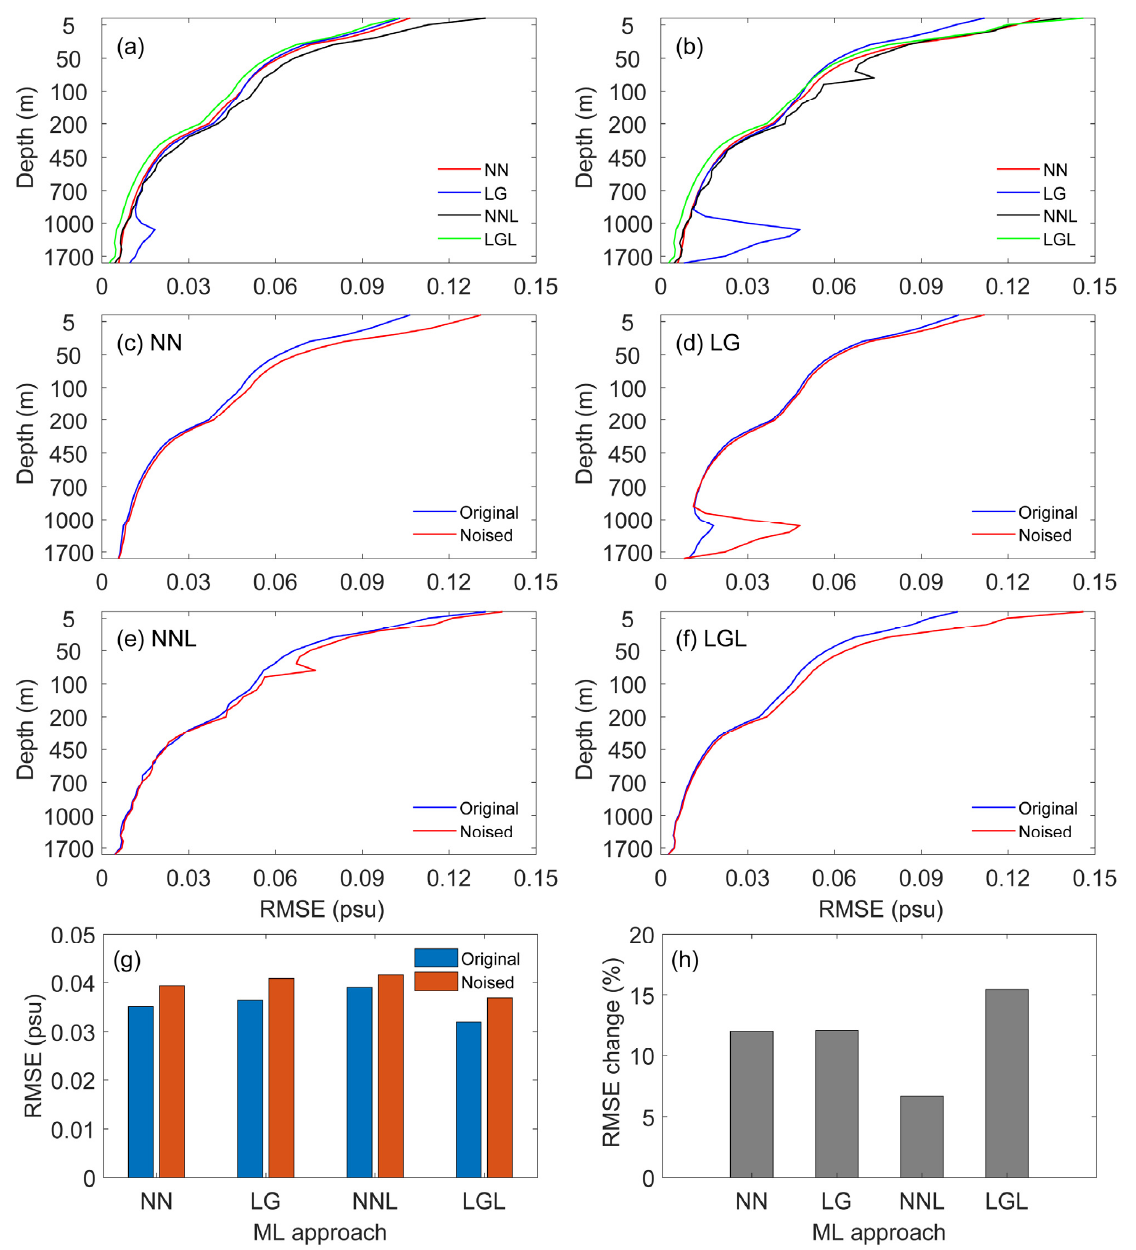
Figure 9. ( a ) Vertical distributions of RMSEs between the reconstructed data and the truth values for the four experiments with the original synthetic dataset. ( b ) Vertical distribution of RMSEs between the reconstructed data and the truth values for the four experiments with the noised synthetic dataset. ( c – f ) Vertical distribution of RMSEs of the individual experiments with the original versus the noised synthetic datasets. ( g ) Bar graphs of average RMSEs in the 1–2000 m range of the four experiments. ( h ) Noise-induced RMSE degradation rates of the four experiments.